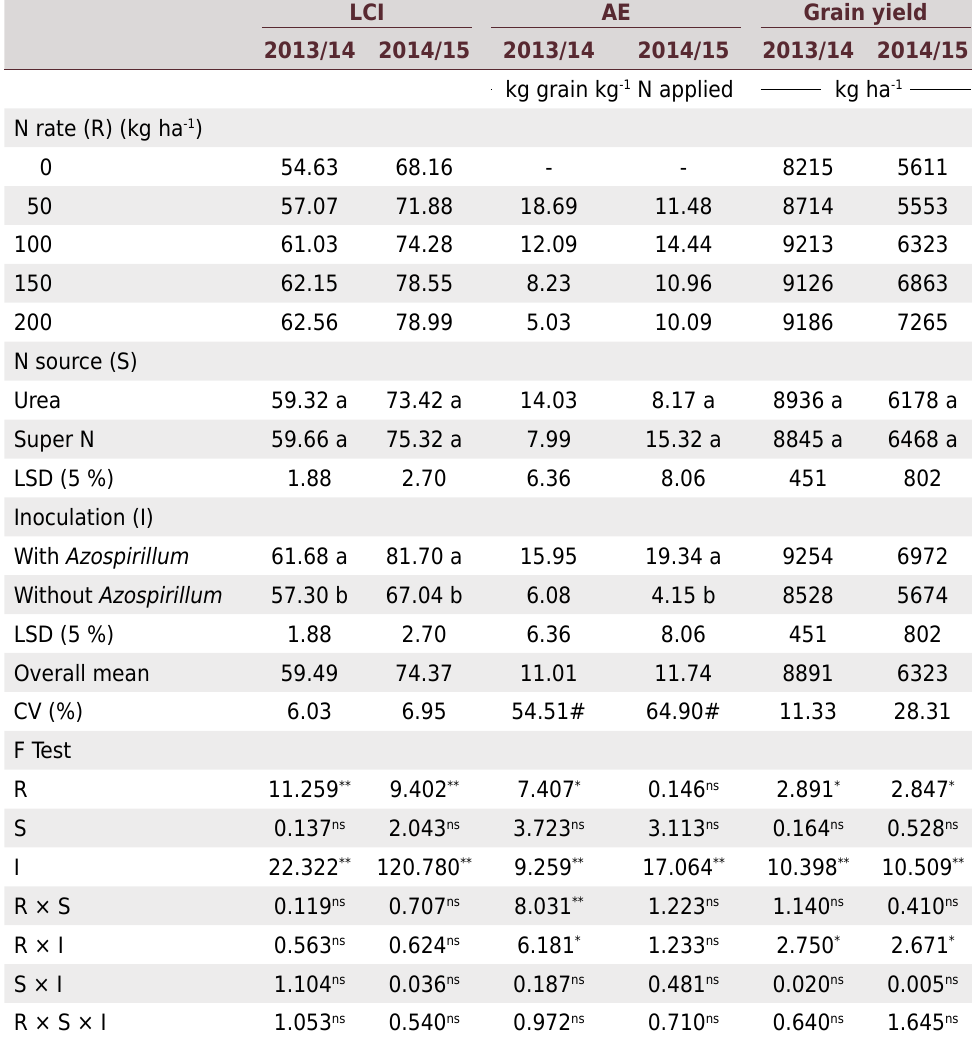
Table 3. Mean and Tukey test concerning leaf chlorophyll index (LCI), agronomic efficiency (AE), and grain yield of corn affected by rates and sources of nitrogen, with or without inoculation with